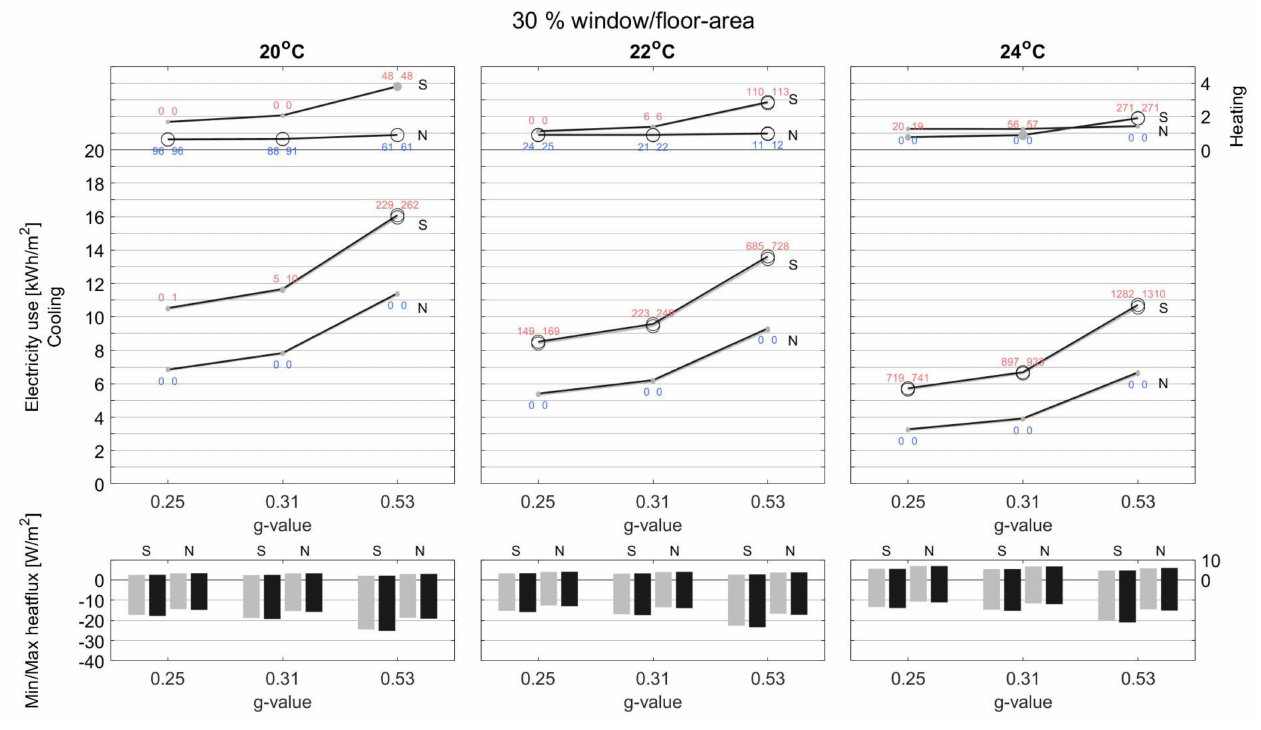
Figure A3. Paris Office.